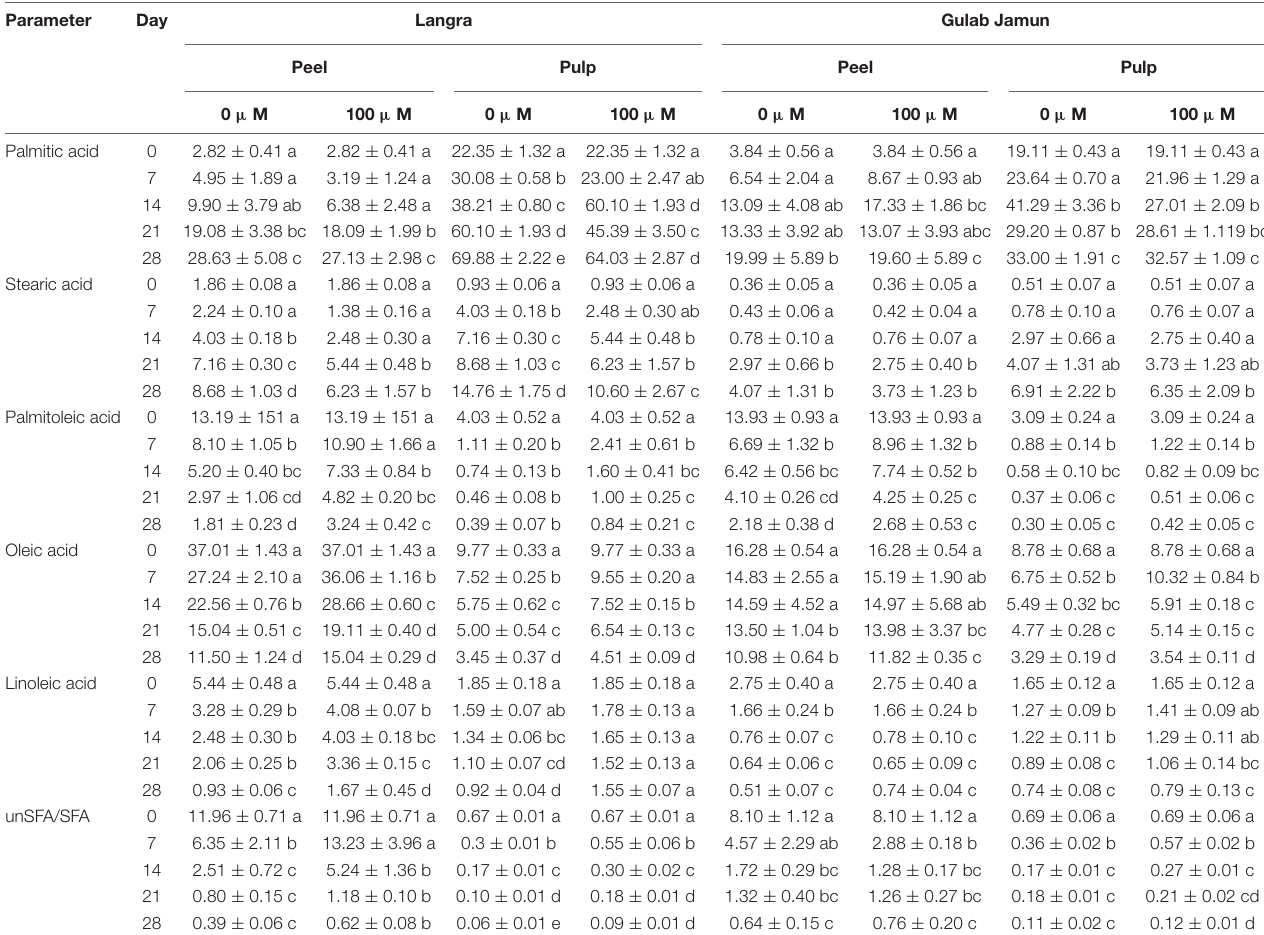
TABLE 1 | Palmitic acid, stearic acid, palmitoleic acid, oleic acid, linoleic acid, and unsaturated/saturated fatty acid (USFA/SFA) in peel and pulp of ‘Langra’ and ‘Gulab Jamun’ mangoes treated with 0 µ M (control) or 100 µ M (treated) melatonin for 2 h followed by low temperature storage at 5 ± 1 ◦ C.